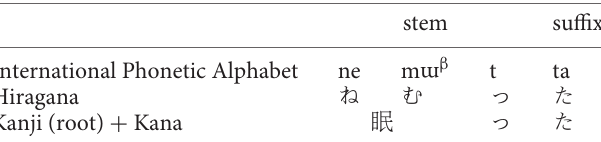
(8) Prime type: non-past verb form, e.g., tatamu “fold” written with kana only and kanji plus kana